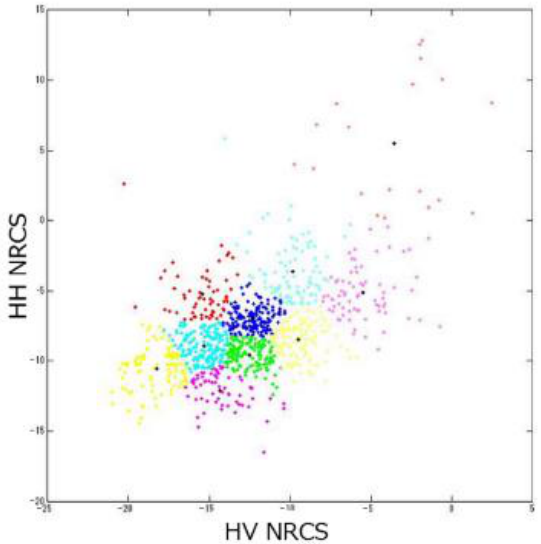
Figure 14. Building classification result using NRCS values (1)